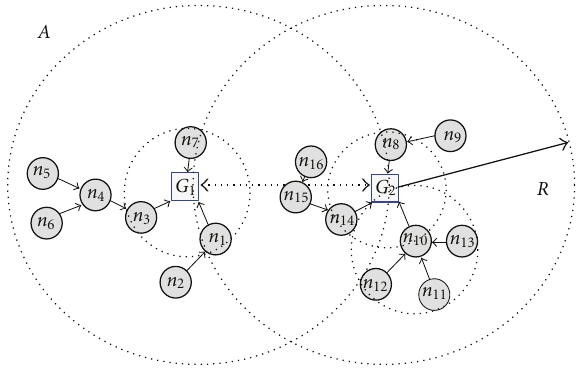
Figure 1: A simple clustered WSN with two gateways and 16 sensor nodes deployed in the area A